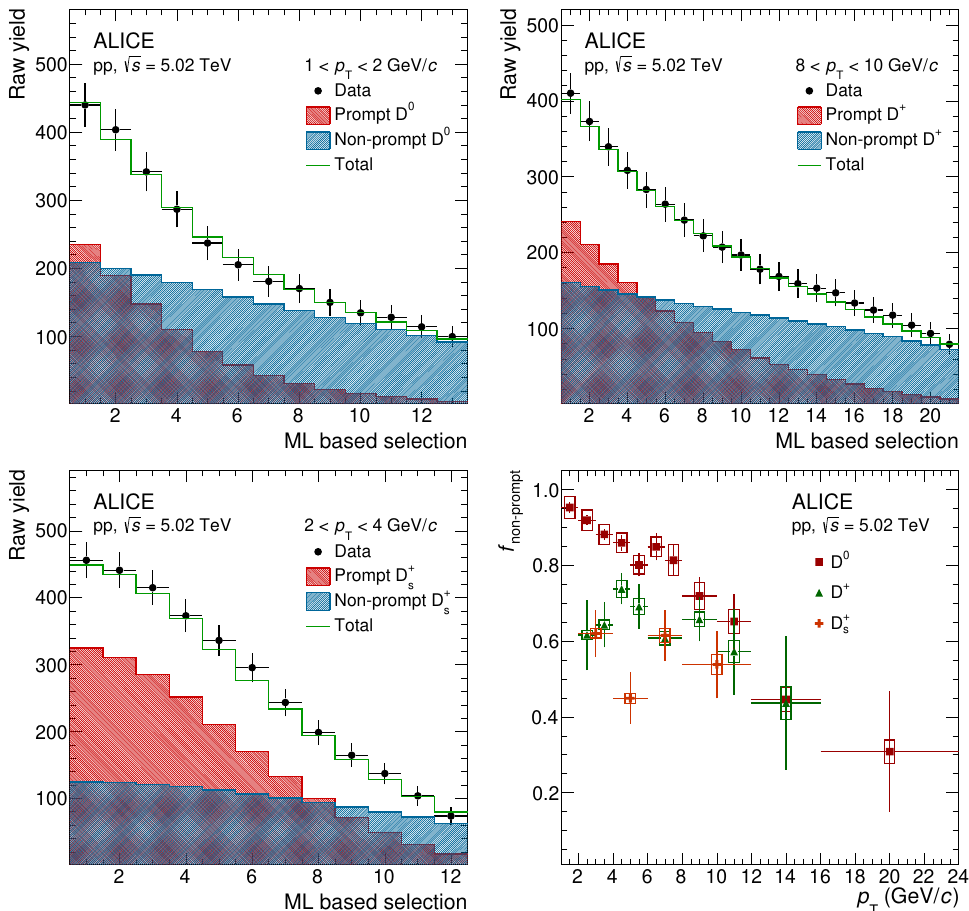
Figure 3 . Examples of raw-yield distribution as a function of the BDT-based selection employed in the χ 2 -minimisation procedure adopted for the determination of f non - prompt of D 0 mesons (top left panel), D + mesons (top right panel), and D + mesons (bottom left panel) for three different s p T intervals. Bottom right panel, f non - prompt fraction as a function of p T obtained for the set of selection criteria adopted in the analysis of non-prompt D